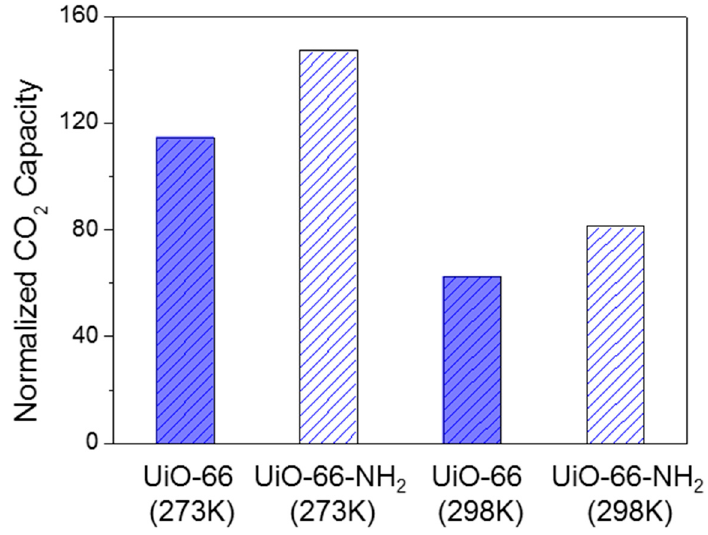
Figure 5. The normalized CO 2 capacities of UiO-66 and UiO-66-NH 2 .